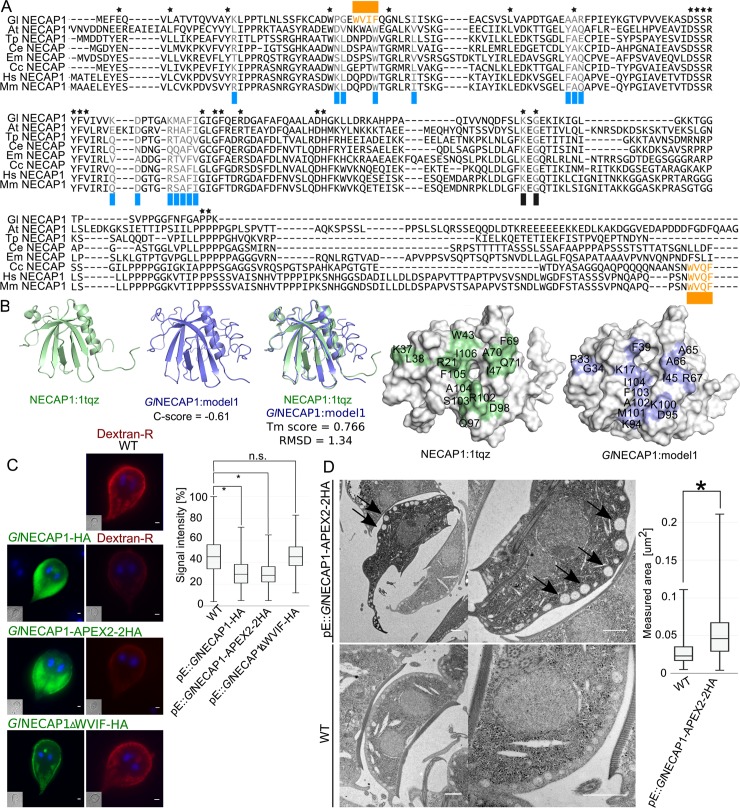
PV morphology and functionality phenotypes caused by GlNECAP1 ectopic expression.(A) Multiple sequence alignment analysis of GlNECAP1 and NECAP1 orthologues from Arabidopsis thaliana (Uniprot accession Q84WV7), Trichinella pseudospiralis (A0A0V1JQ20), Caenorhabditis elegans (Q9N489), Echinococcus multilocularis (A0A087VZS0), Ceratitis capitata (W8CD89), Homo sapiens (Q8NC96) and Mus musculus (Q9CR95) identifies conserved motifs and residues for interaction with AP2. GlNECAP1 presents partial conservation, with a WXXF motif (orange) shifted to the N-terminus with respect to other orthologues. (B) Ab initio template-based 3D modelling of G. lamblia and H. sapiens NECAP1 (1tqz) homologues predicts similar structures, with conservation of key residues involved in the interaction between NECAP1 proteins and AP2 complexes (shaded in blue and green). (C) Wild-type non-transgenic control cells (WT) and cells expressing either epitope-tagged GlNECAP1 reporters GlNECAP1-HA, GlNECAP1-APEX2-2HA or the ΔWVIF deletion construct GlNECAP1ΔWVIF-HA (green) were tested for Dextran-R (red) uptake. Dextran-R signal intensity after uptake was significantly (p<0.05) decreased in GlNECAP1-HA- and GlNECAP1-APEX2-2HA- expressing cells when compared to wild-type controls and GlNECAP1ΔWVIF-HA-expressing cells (box-plot). (D) Quantitative tEM analysis of GlNECAP1-APEX2-2HA-expressing cells (upper panels) and wild-type non-transgenic cells (WT; lower panels) shows visibly enlarged PVs in GlNECAP1-APEX2-2HA-expressing cells, with a statistically significant (p<0,05) increase in the median of measured area of peripheral vacuoles (in μm2; box-plot).